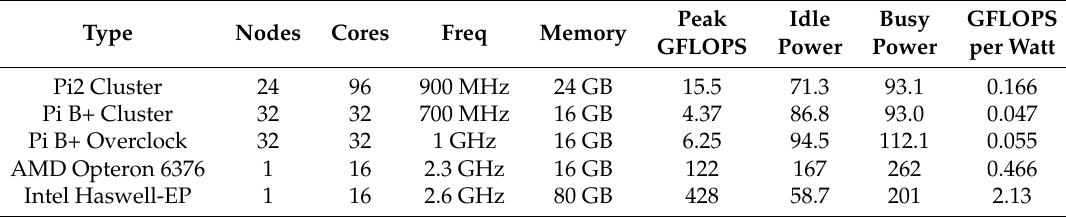
Table 3. Peak FLOPS cluster